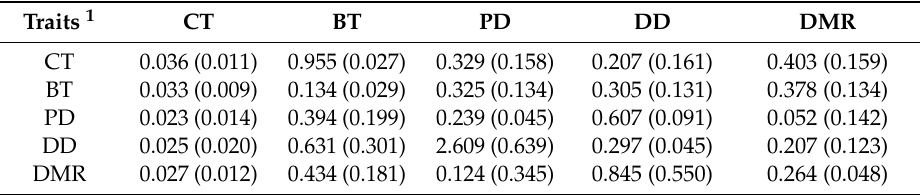
Table 4. Genetic correlation (upper triangle), covariance (lower triangle), and heritability (diagonal) of sperm morphology abnormalities estimated by a five-trait linear mixed model in the Duroc boar population (estimate